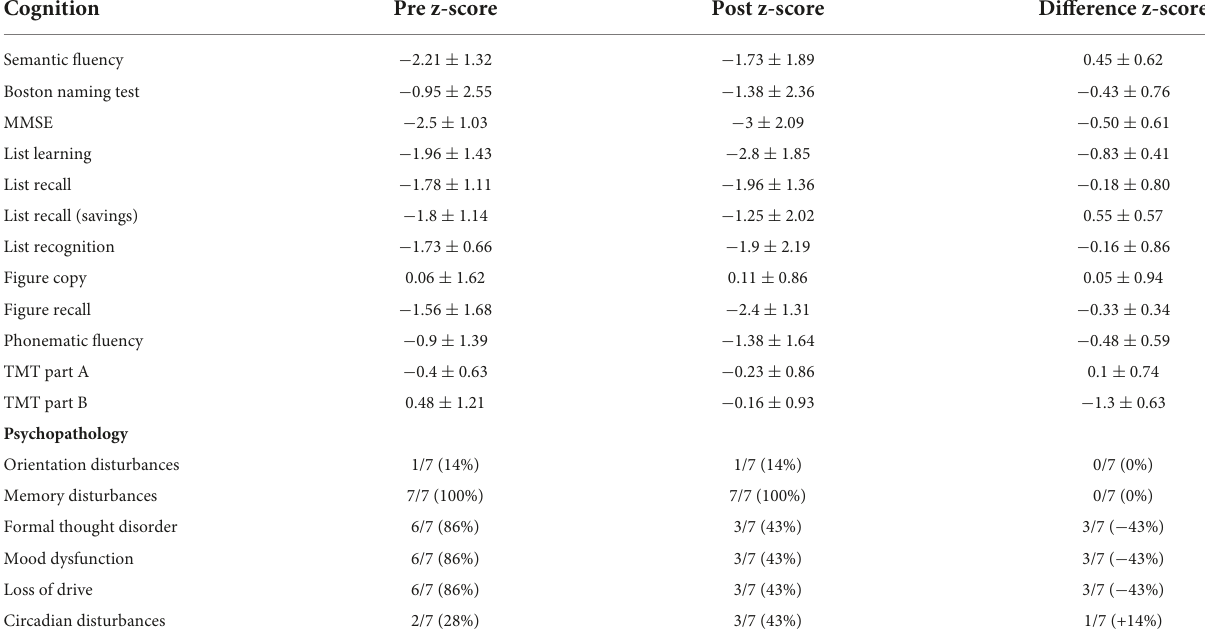
TABLE 2A Neuropsychological and psychometric data in patients with cognitive dysfunction.